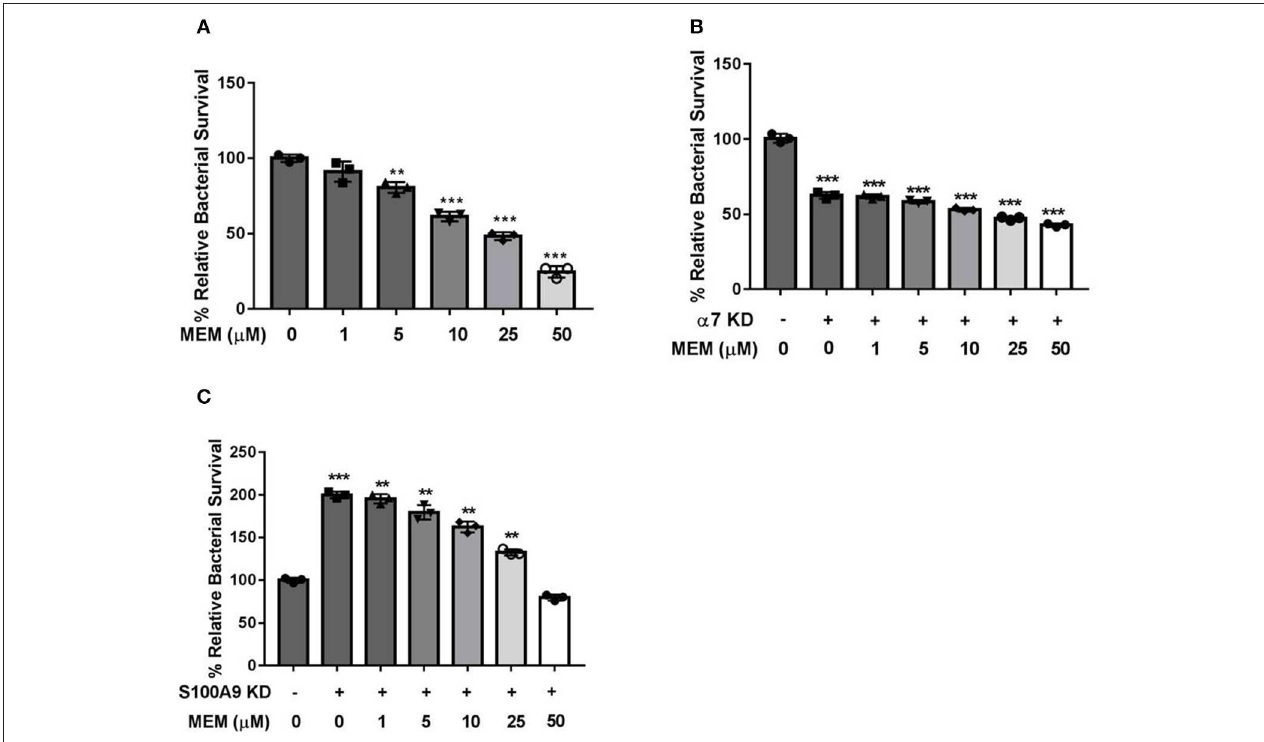
FIGURE 4 | CHRNA7 knockdown led to a failure of MEM-enhanced intracellular killing ability of PMNs. A total of 1 × 10 6 of PMNs were cultured in 24-well plates and transfected with CHRNA7 or S100A9 siRNA. Cells were treated with E. coli E44 (MOI = 50) or/and different concentrations of MEM for 2h. (A) Bacterial survival in PMNs with titration of memantine treatment; (B) Survival of E44 in PMNs with ( + ) or without (–) CHRNA7 knockdown after treatment with different concentration of MEM; (C) Survival of E44 in PMNs with ( + ) or without (–) S100A9 knockdown after treatment with different concentration of MEM. Relative survival was expressed as an n-fold increase or decrease relative to the basal level (Cells without siRNA and MEM treatment). Each bar represents the average of three different experiments ± SD. Scatter plots in the bar graphs represent the three biological replicates. ** P < 0.01, *** P < 0.001 compared with the control.